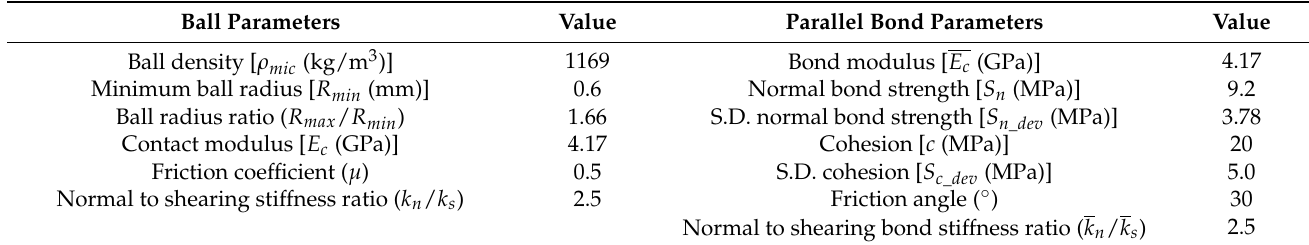
Table 3. Microscopic properties of the particles and bonds.